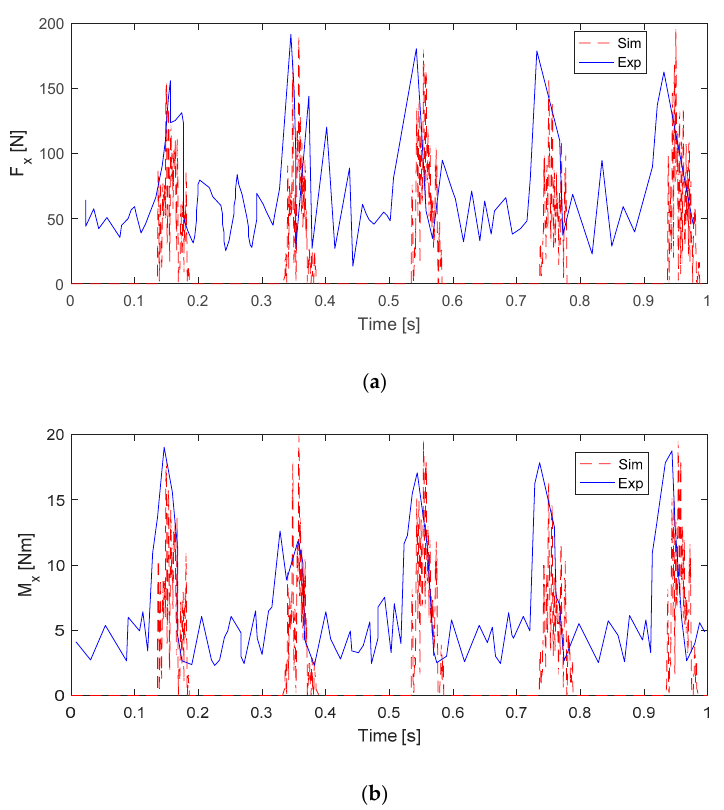
Figure 10. Simulated and measured ice loads during ice-milling process. ( a ) Force comparison between the simulation and the model test. ( b ) Torsional moment comparison between the simulation and the model test. Table 3. Comparison of peak ice force and moment.